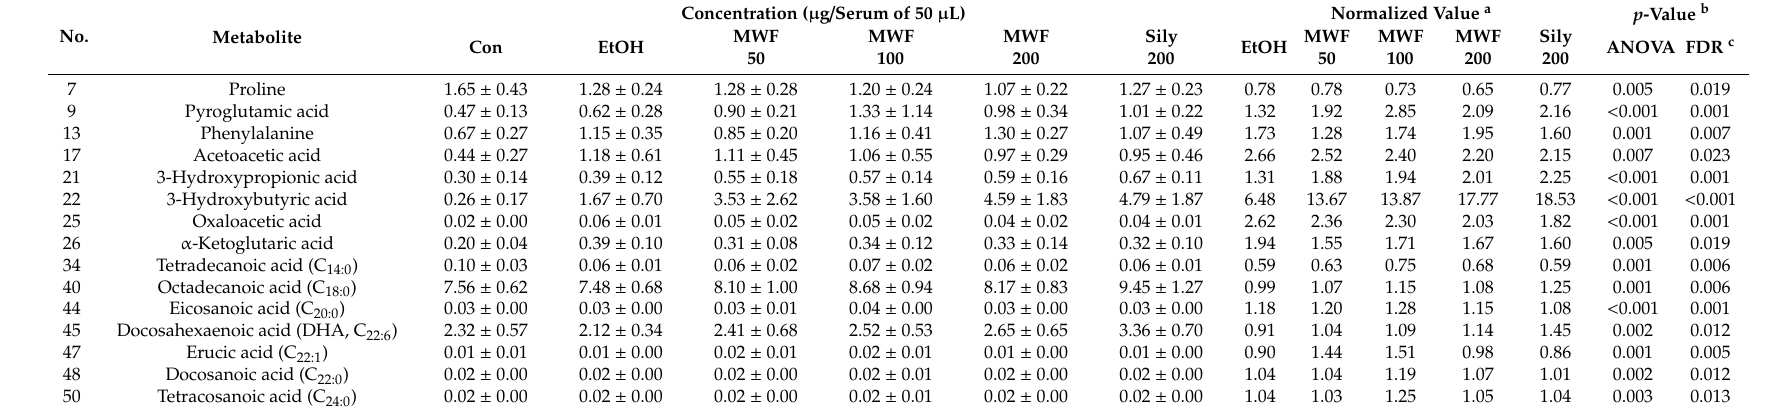
Table 1. Levels of 15 significant metabolites in serum from Con, EtOH, MWF50, 100, 200, and Sily200 groups. MWF, mealworm fermentation